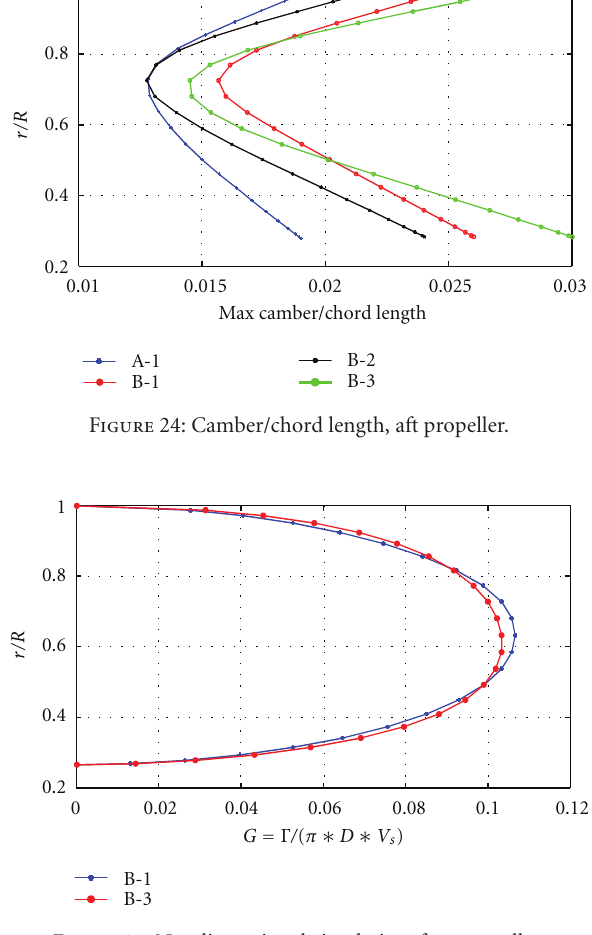
Figure 25: Nondimensional circulation, fore propeller.